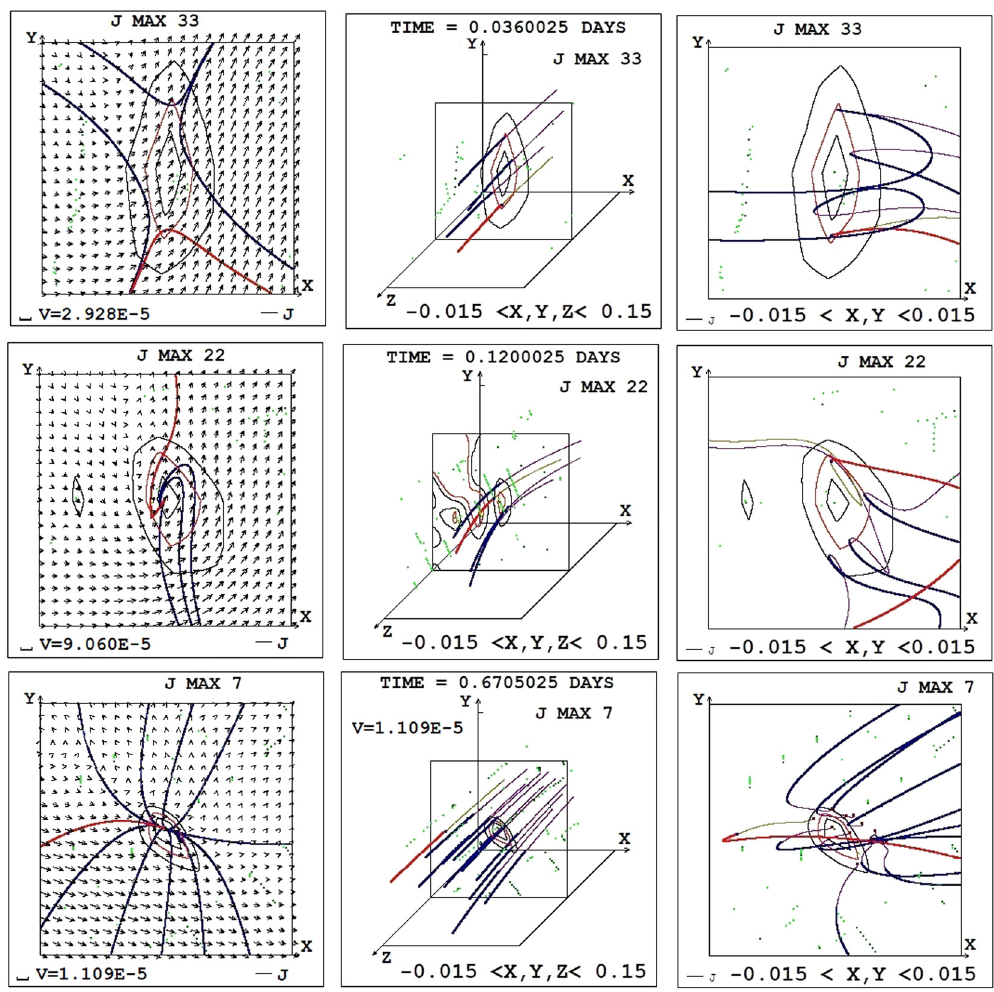
Figure 5: Field con fi gurations near singular lines in the region with a linear size of 0.03 dimensionless units ( 12 mM ) in the centers of which the maxima of the current density are located. The Z axis is directed along the magnetic fi eld vector taken at the point of maximum current density. The plane ( X Y , ) perpendicular to the magnetic fi eld vector is the plane of the con fi guration in which the current sheet is best expressed. Left column: Plane magnetic fi eld con fi gurations and plasma fl ows as on panels of Figure 4. Middle column: 3D con fi gurations of the magnetic fi eld near the point of maximum current density. Right column: Projections of magnetic lines onto the plane of the con fi